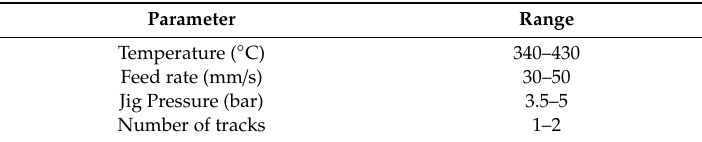
Figure 6. The time at which each point is between melting and degradation temperatures: ( a ) zig-zag trajectory parallel to x ; ( b ) zig-zag trajectory parallel to y ; ( c ) spiral trajectory. The different joining parameters studied are shown in Table 5. Table 5. Tested parameters. Table 5. Tested parameters.